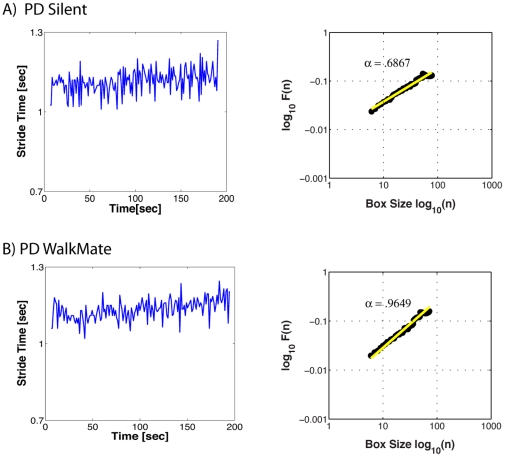
Examples of two trials.On the left, the stride times of one leg are plotted against trial time. On the right, the DFA technique plots the average fluctuation per box size. Using DFA, a scaling exponent α≈0.5 corresponds to rough and unpredictable white noise; α≈1.0 corresponds to 1/f-like noise and long-range correlations [26]. The mean and SD of stride times are similar in both trials, but the fractal scaling differs considerably. During the Silent condition (A), the PD patient's strides are unpredictable and akin to white noise, whereas during interactive rhythmic stimulation (B), the stride fluctuations have a 1/f-like structure.